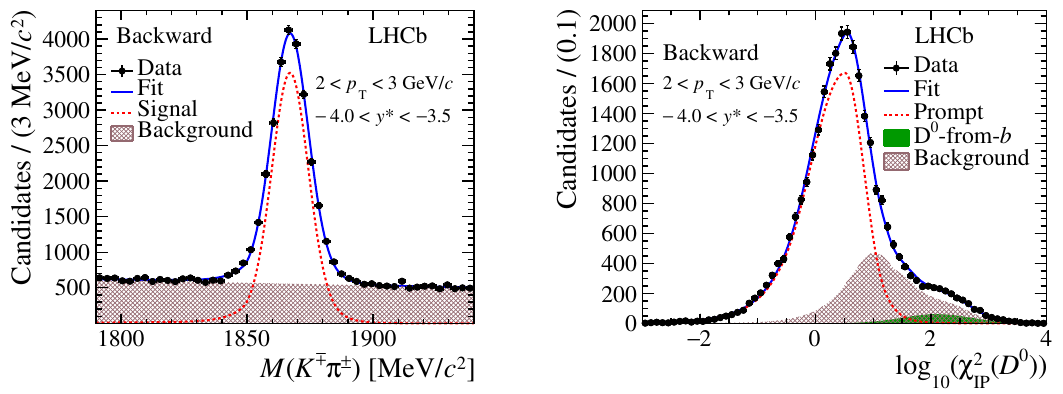
( (cid:31) 2 ( D 0 )) distributions and the (cid:12)t result for the 10 IP